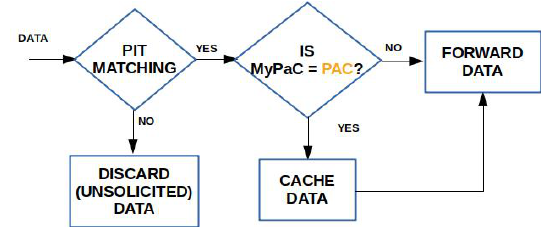
Figure 5. Data processing in the presence of PaC-based